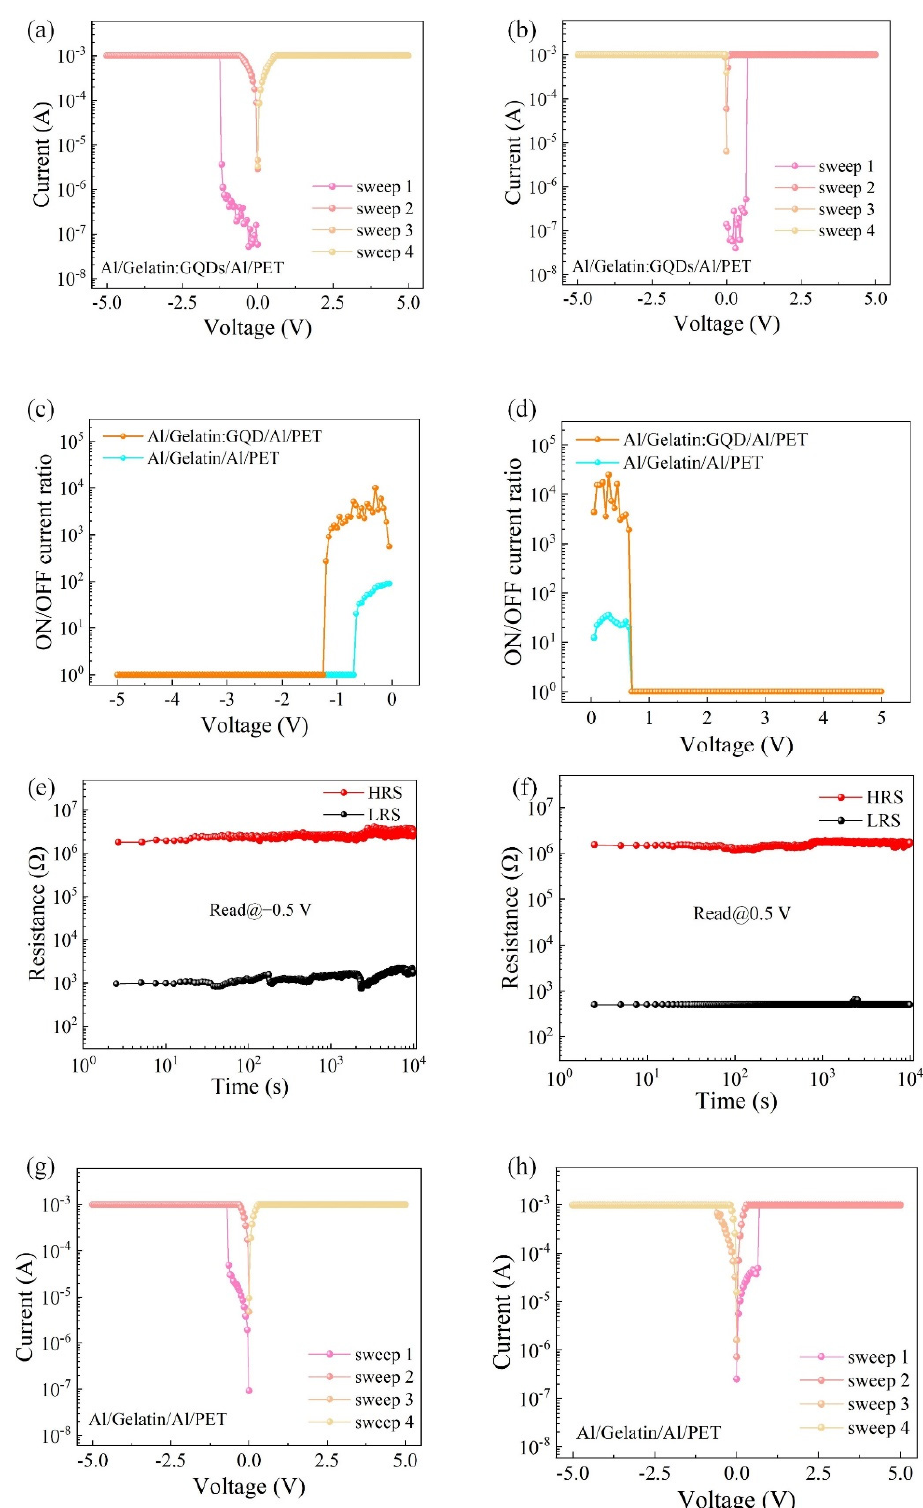
Figure 2. I-V characteristic curve of the Al/gelatin:GQD/Al/PET device: ( a ) initial negative voltage; ( b ) initial positive voltage; ( c , d ) switching current ratio; ( e , f ) holding characteristics of the I-V char- acteristic curve of the Al/gelatin/Al/PET device; ( g ) initially applied negative voltage; ( h ) initially applied positive voltage.